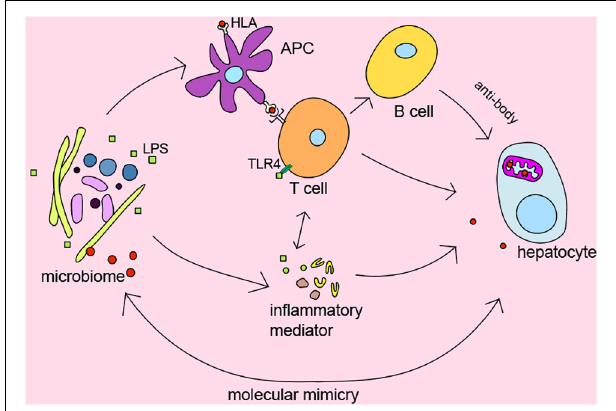
FIGURE 2 | The role of microbiome in pathogenesis of